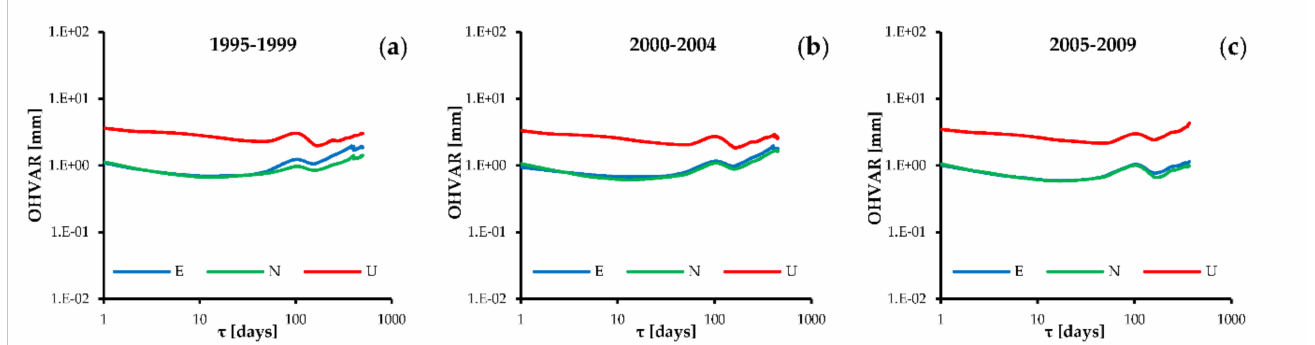
Figure 8. ( a – c ) Mean values of the OHVAR (Y-axis) as a function of τ (averaging time, X-axis) for each of the components and periods in the time series